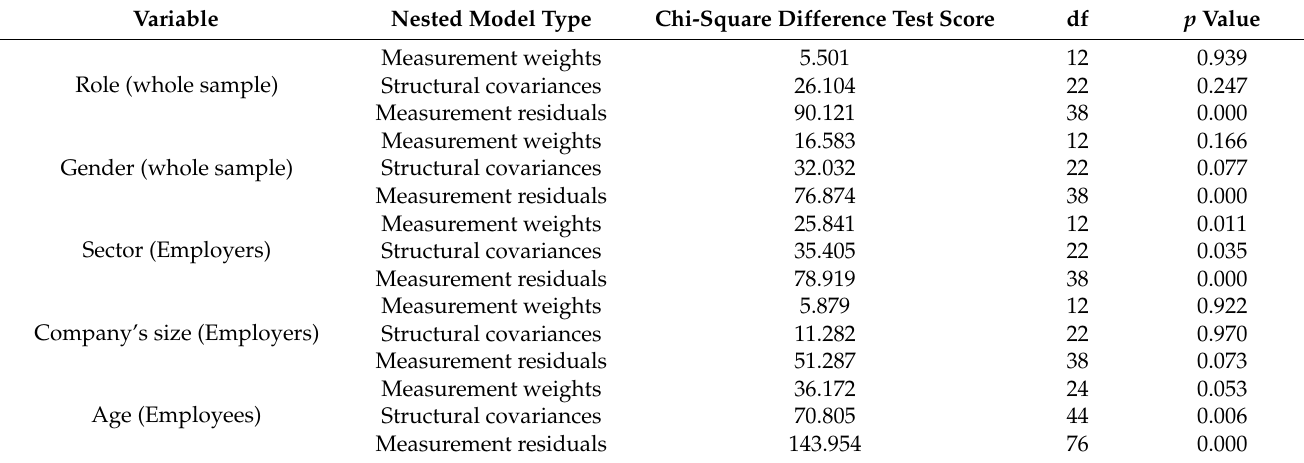
Table 5. Chi-square difference tests for nested models of ADS